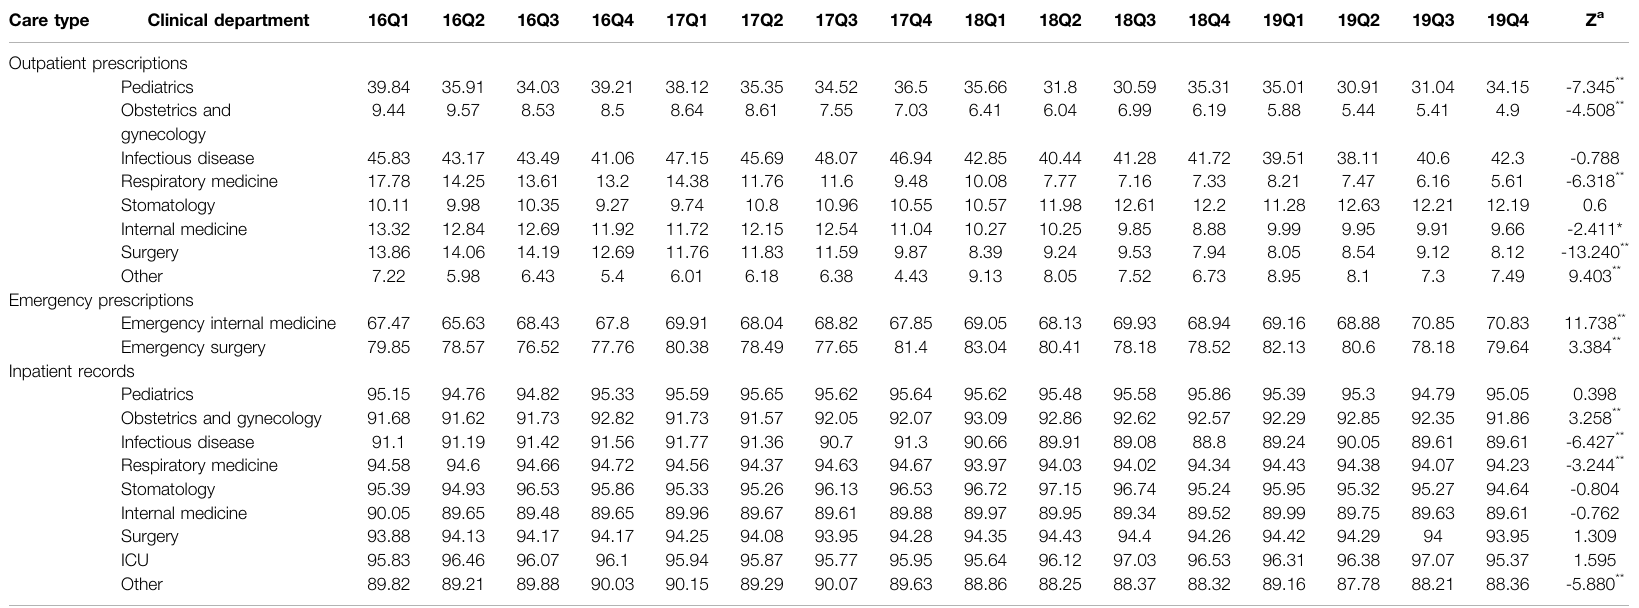
TABLE 4 | Changes in proportion of prescribed with parenteral antibiotics in different clinical departments, 2016 – 19. Care